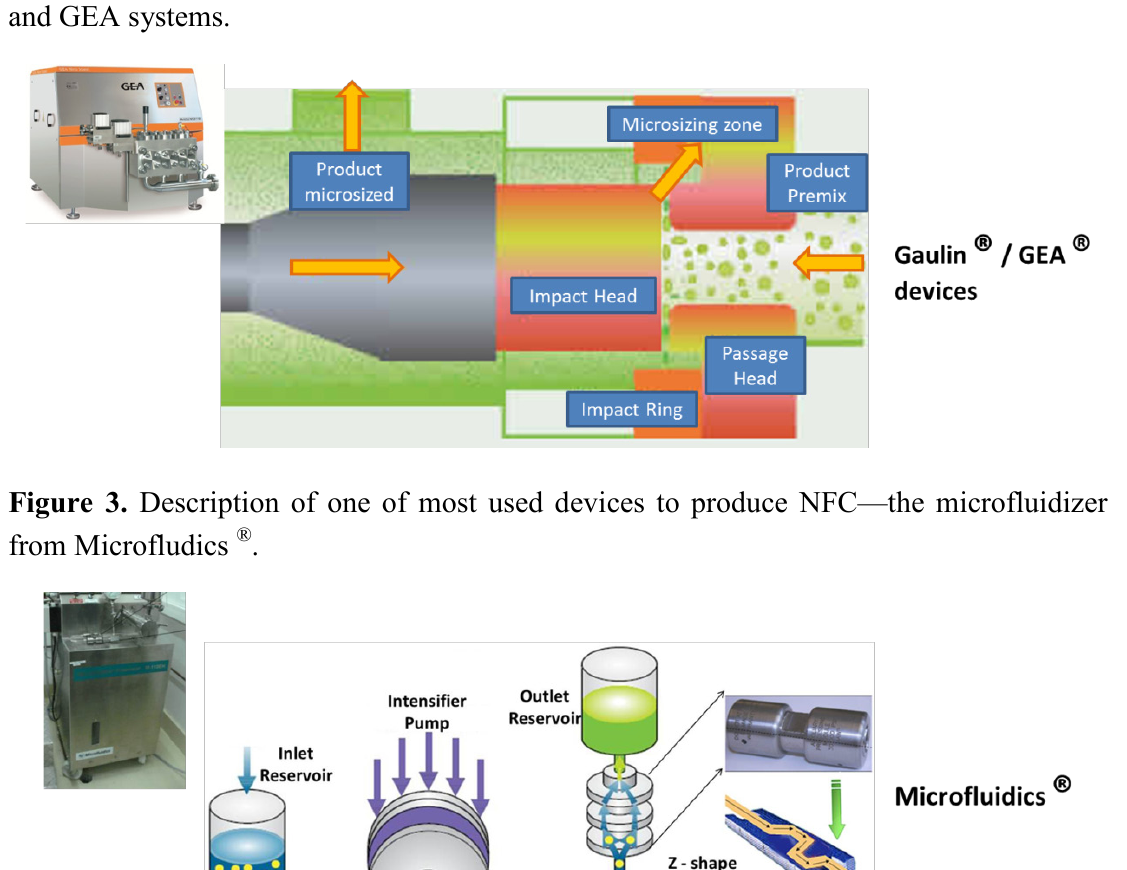
Figure 2. Description of homogenizer systems commonly used for NFC production—Gaulin and GEA systems.